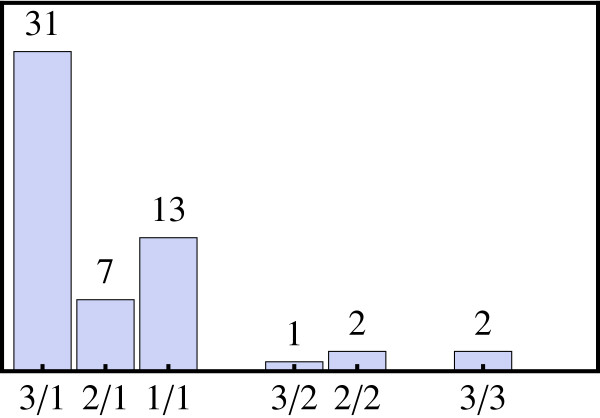
Homoeologous sequences and the Wheat GeneChip. The number of probesets with a significant (≥ 7) number of probes matching to 237 homoeologous sequences known to be expressed at some level is shown in this histogram. Categories are labelled as x/y, indicating that x out of 3 homoeologs are represented on the Wheat Genechip by y probesets. For example, "3/1" means that all (or almost all) probes from a single probeset match perfectly to all three homoeologs of a gene and hence that individual contributions from the homoeologs cannot be resolved; "3/2" indicates that the contribution from one homoeolog can be resolved, while the other two hybridize to a single probeset; similarly, "2/1" indicates that two homoeologs match probes from a single probeset, while the third homoeolog does not significantly hybridize to any probes. In only two cases, indicated by "3/3", can the expression of each of the three homoeologs be detected individually by probes from three separate probesets, while in the majority of cases homoeologous triplets (51 out of 56) are significantly matched by probes from only a single probeset.